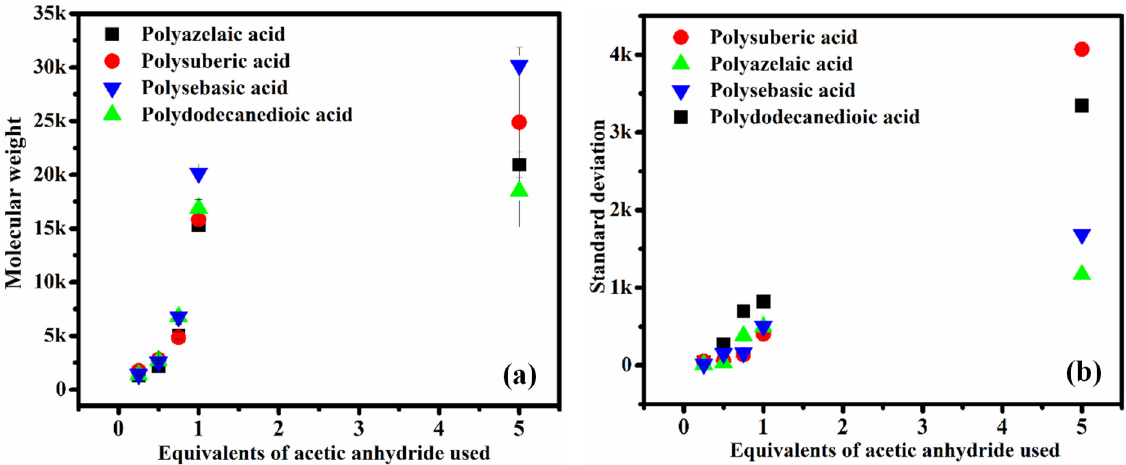
Figure 4. ( a ) Variation of polyanhydride weight average molecular weights and ( b ) variation of standard deviation as a function of acetic anhydride to diacid monomer molar ratio. Polyanhydrides synthesized in triplicate at 160 °C under vacuum (~10 m bar) for 4 h.